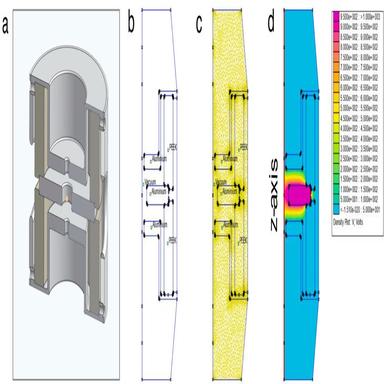
Finite element calculation process of NanoMi lens. a) CAD model of NanoMi Lens as viewed in OnShape. b) Cross section of CAD model imported into FEMM, with appropriate materials designated. c) Triangulation of the 2D CAD drawing. d) Calculated potential surrounding the charged electrode.